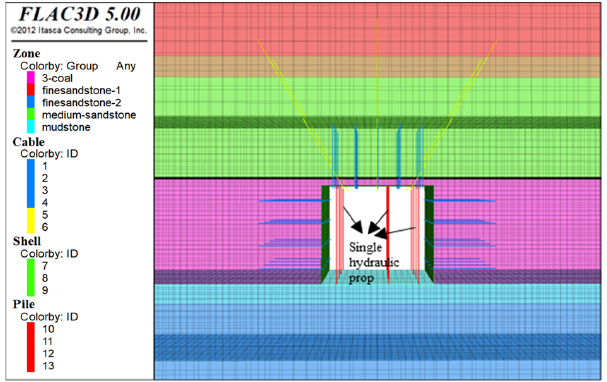
Figure 9. A mining roadway with the single hydraulic prop advanced support.